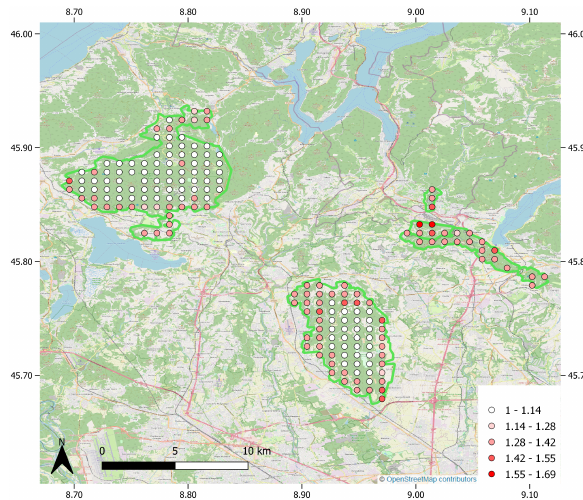
Figure 4. Map of the ratios [%] between the 90th percentile and the baseline line values (night-time records) of the time series of Facebook users’ counts. The ratio is computed at each location (Bing tile centre) within parks and used as a metric to infer the most visited locations (Basemap:© OpenStreetMap